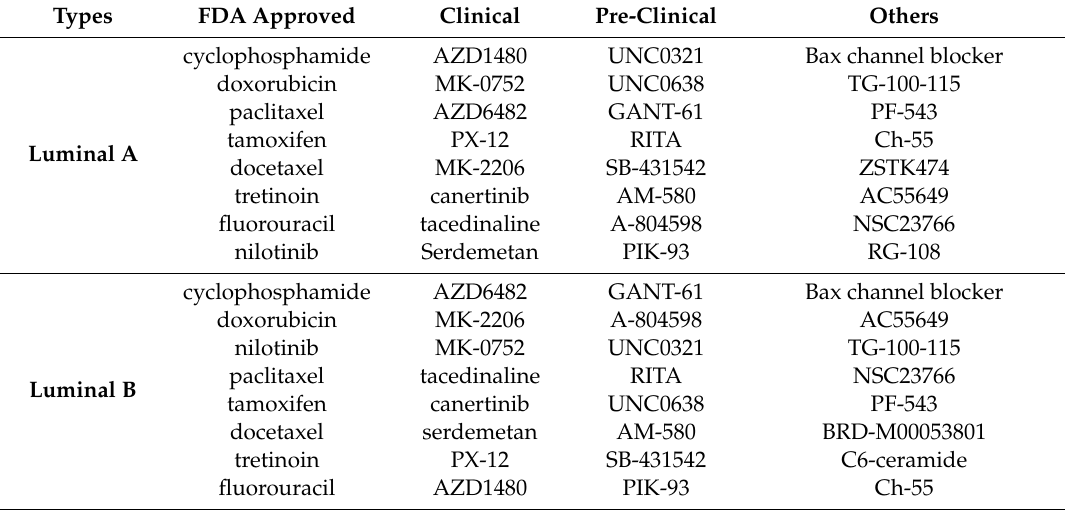
Table 5. The most frequent recommended drugs for 1097 patients in five subtype breast cancer